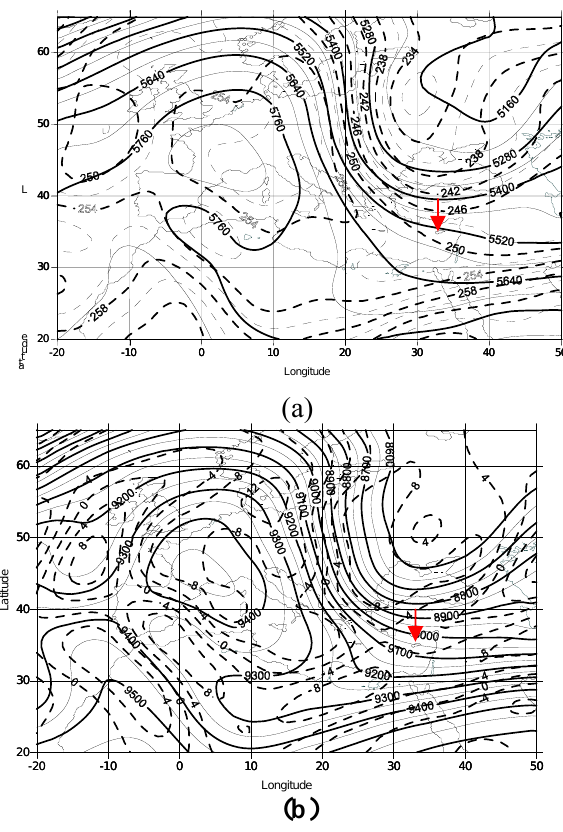
Fig. 6. As Fig. 4, but for 0000 UTC 28 January 2008.